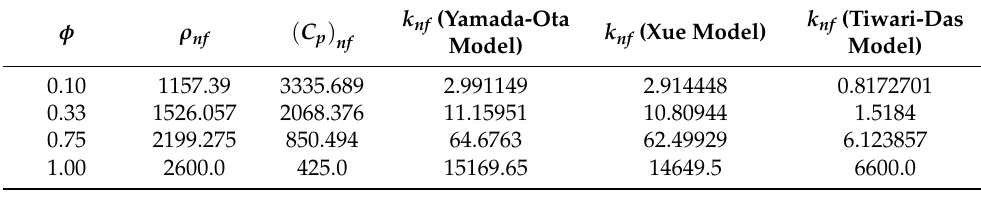
Table 3. Physical properties of